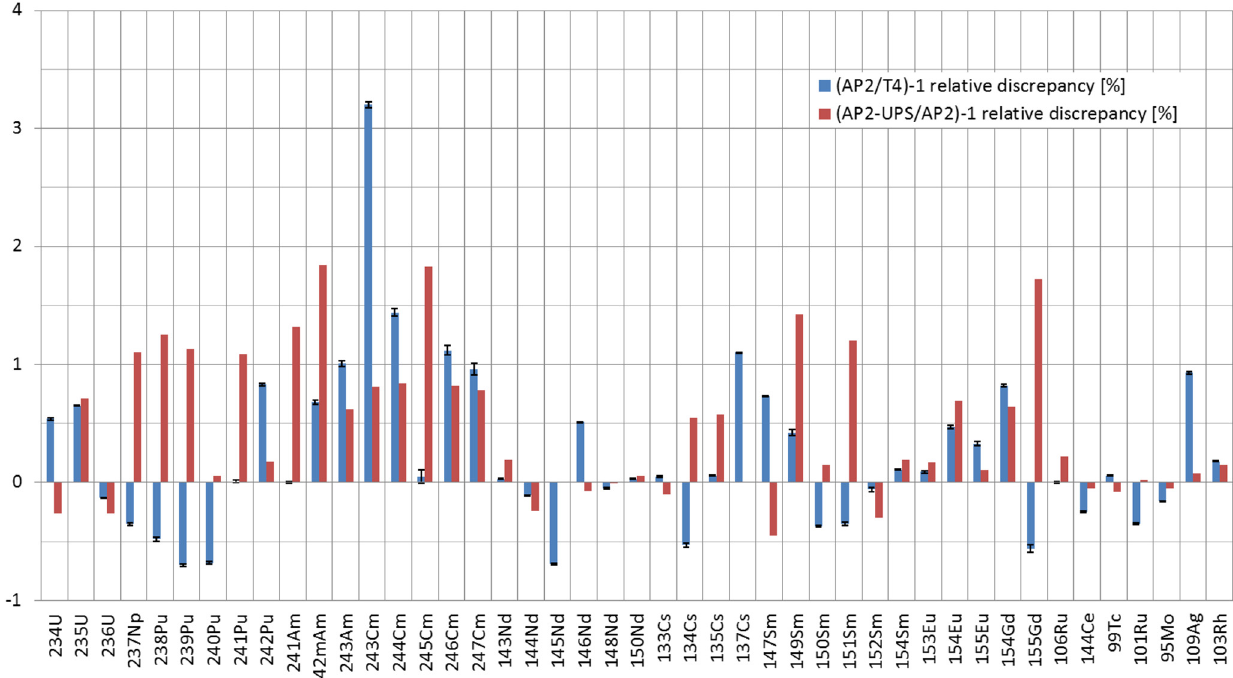
Fig. 3. Differences obtained on the isotopic concentrations (normalized to 238 U concentration) on a pin-cell geometry for a 3.7% 235 U- enriched UOX fuel at 40 GWd/t between i) in blue: APOLLO2 (AP2) and TRIPOLI-4 depletion calculations (T4), ii) in red: two APOLLO2 depletion calculations, with (AP2-UPS) and without (AP2) resonant up-scattering effects. Error bars represent the statistical uncertainty provided by the TRIPOLI-4